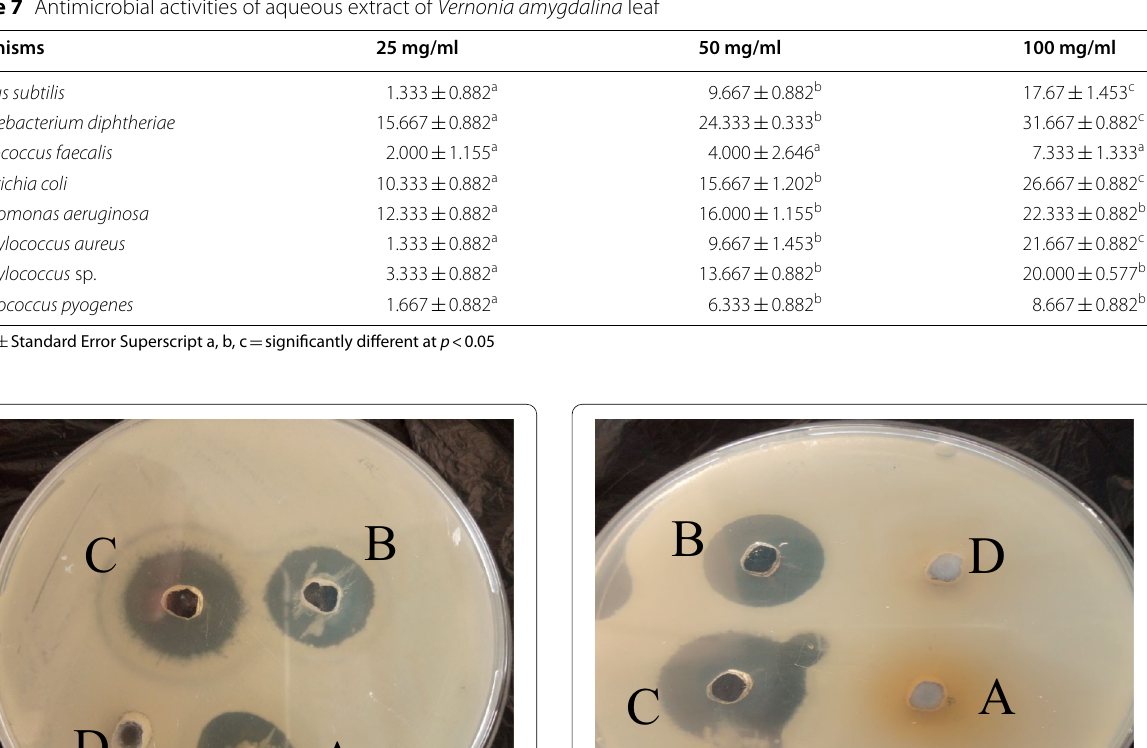
Mean Standard Error, Superscript a, b, c ± Table 7 Antimicrobial activities of aqueous extract of Vernonia amygdalina leaf